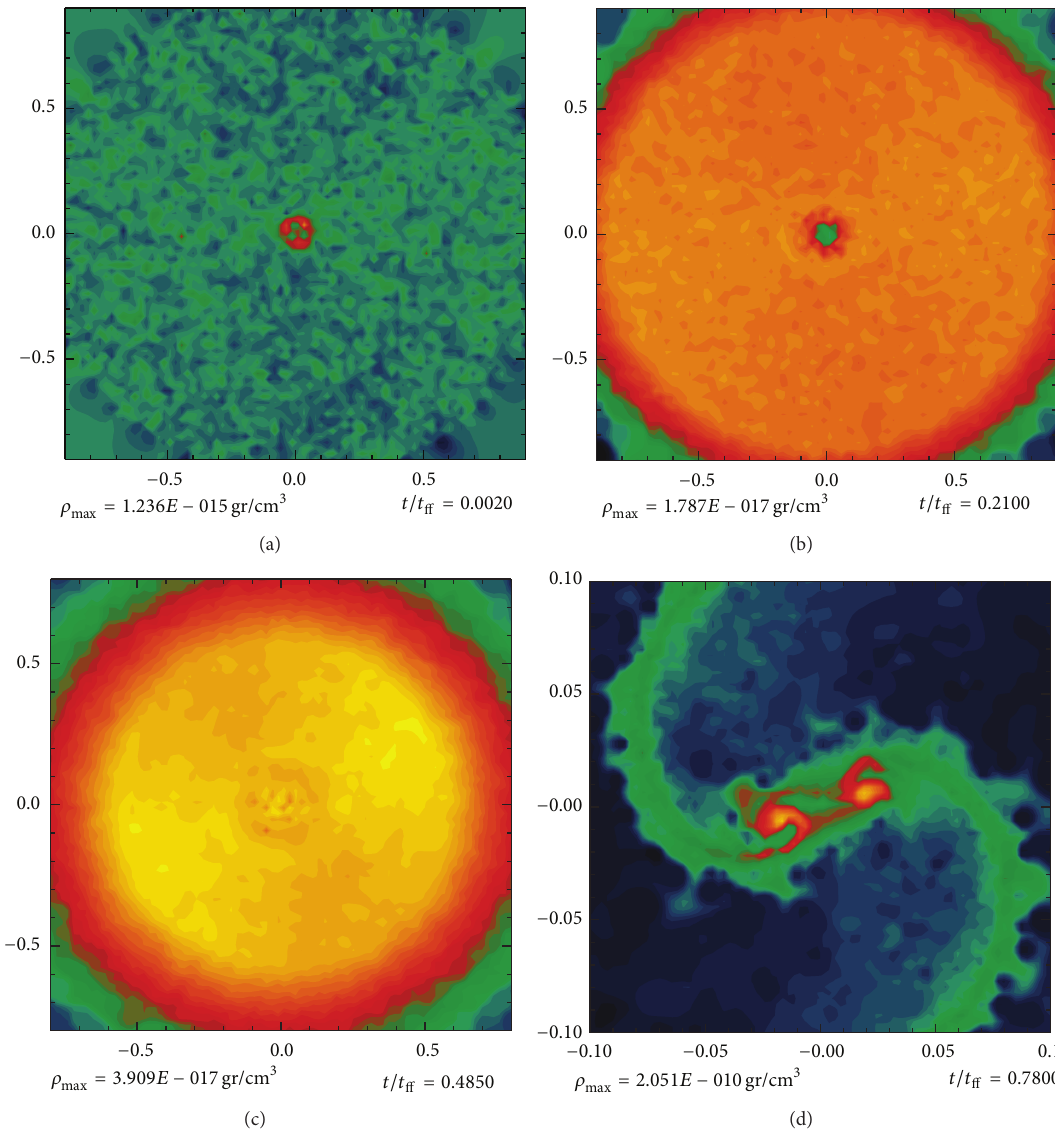
Figure 11: Iso-density plots for a thin slice of matter parallel to 𝑥𝑦 plane for the collapse of the rotating core with wind particle rotating as the core particles do, that is, Ω 𝑤 = Ω 𝑐